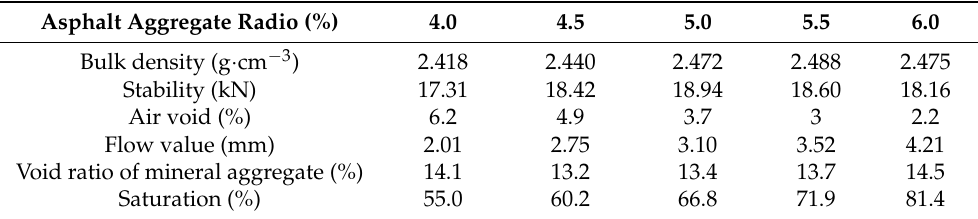
Table 9. Marshall test results of CMA